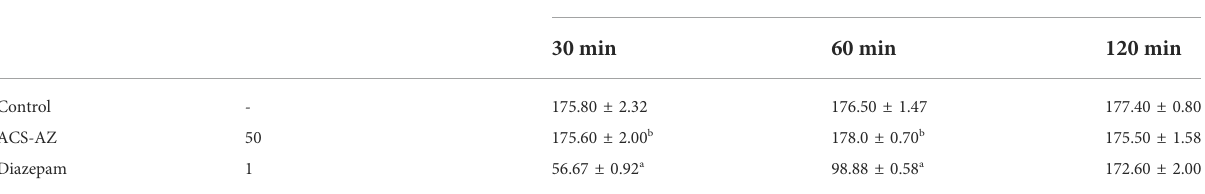
TABLE 4 Rota-rod test after 30, 60, and 120 min of ACS-AZ (50 mg/kg) and Diazepam (1 mg/kg) treatments.